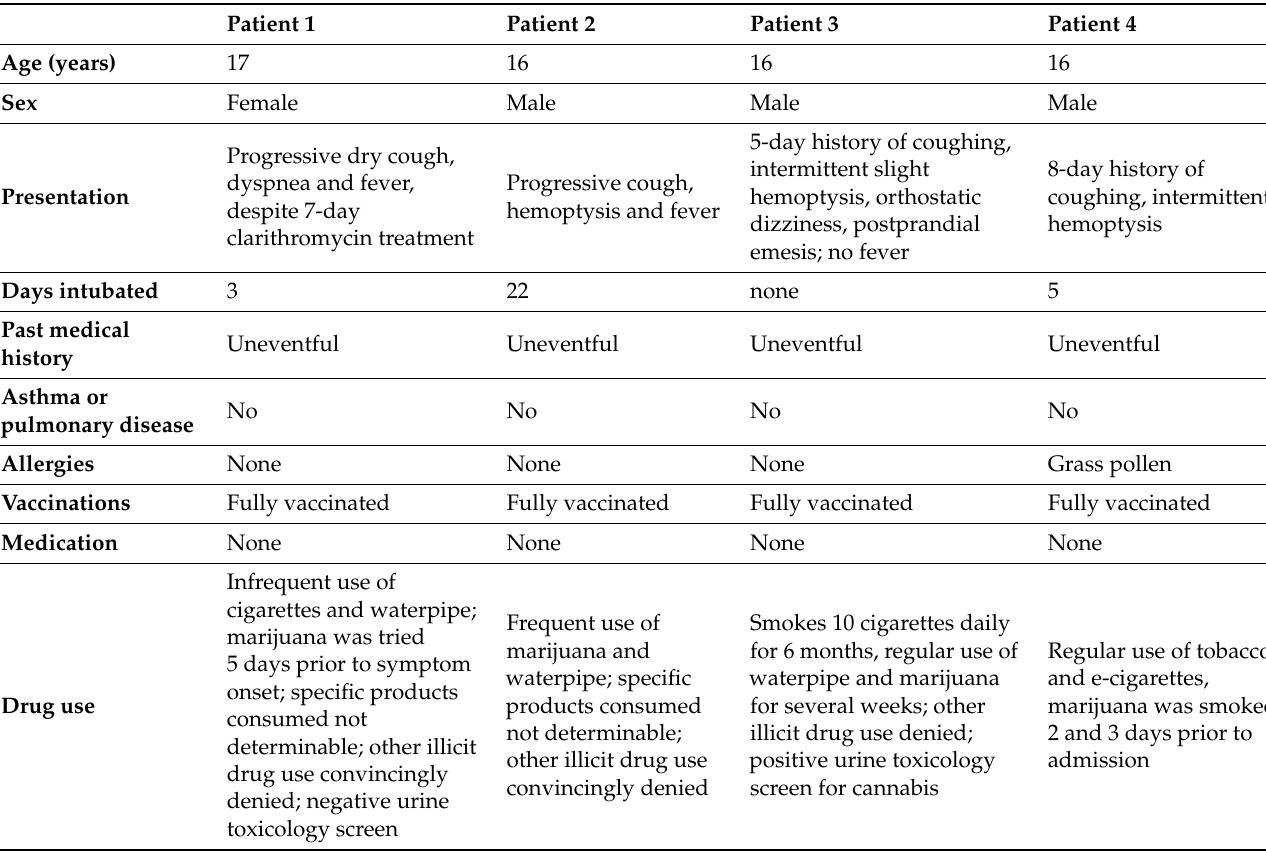
Table 1. Patient information and medical